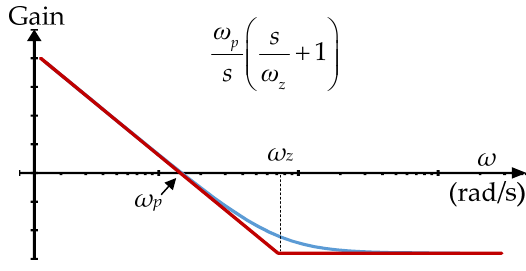
Figure 6. Bode diagram of the open ‐ loop transfer function of the proposed decoupled control.